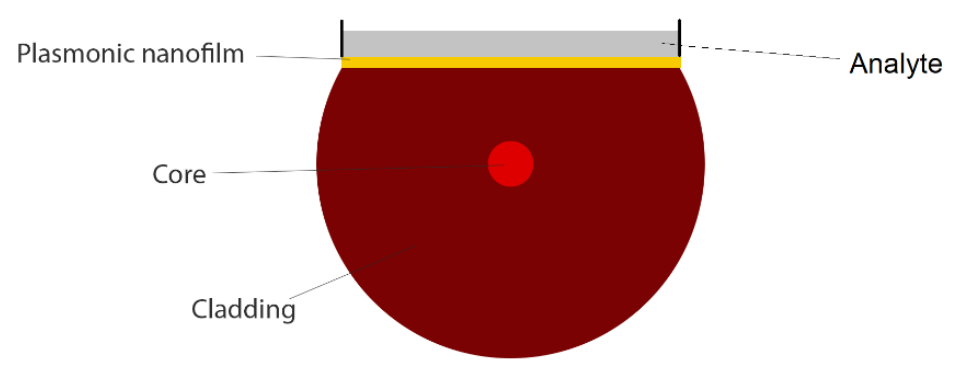
Figure 6. Cross section of a side-polished (D-shaped) plasmonic fiber-optic biosensor for liquid analyte detection.